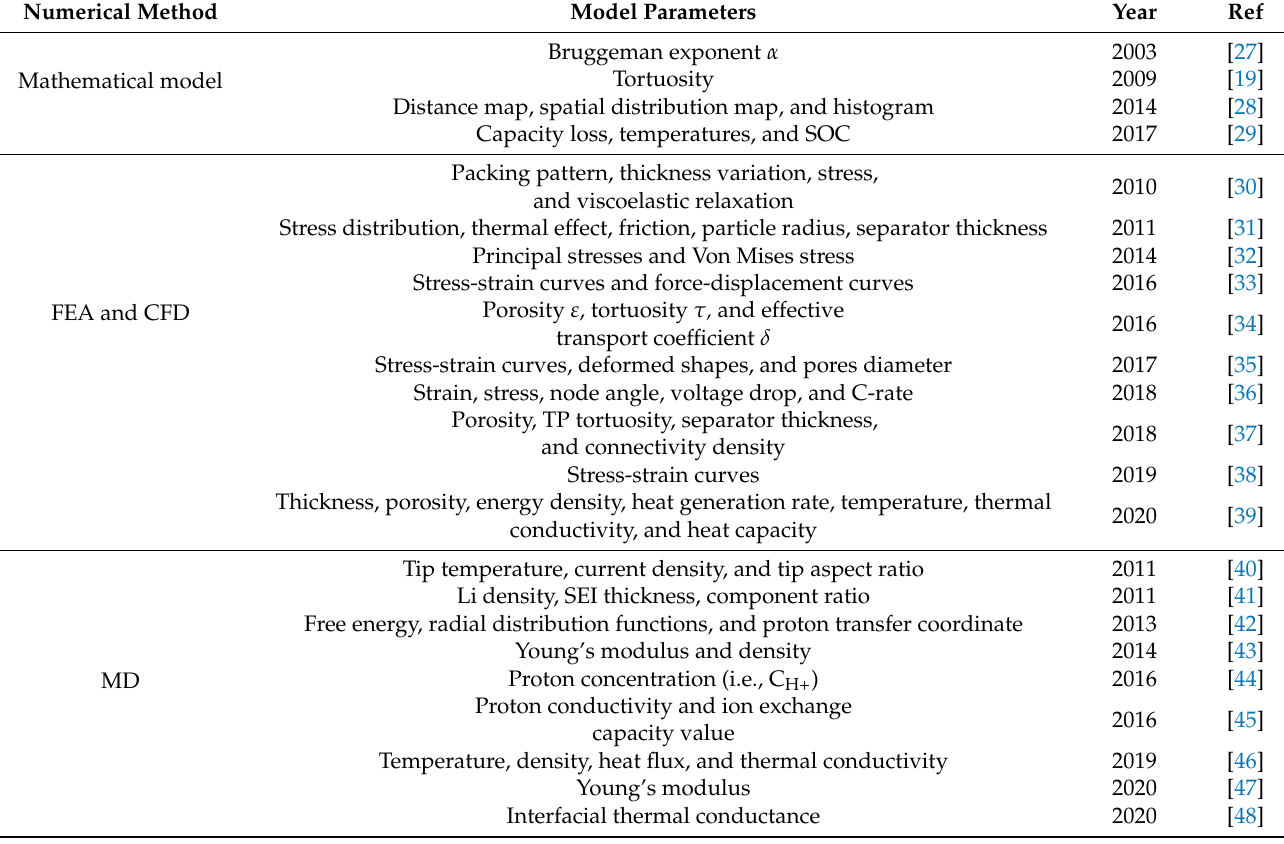
Table 2. The summary of the reviewed numerical studies for separators with model parameters. Numerical